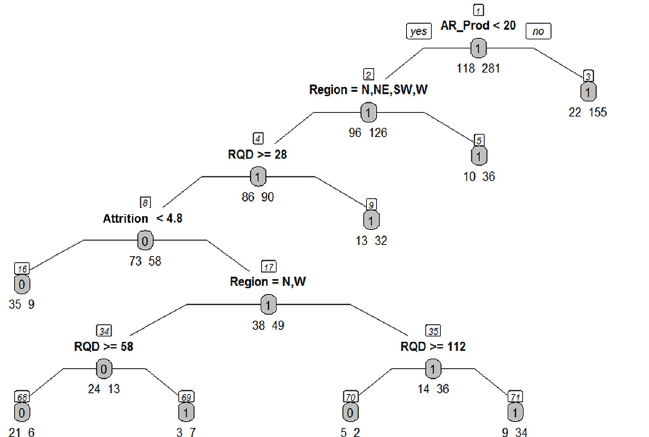
Figure 3. Classi fi cation